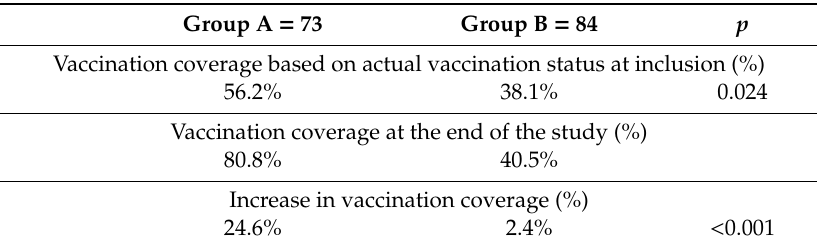
Figure 4. DT-IPV vaccination status and vaccination of patients included in the HOSPIVAC study.